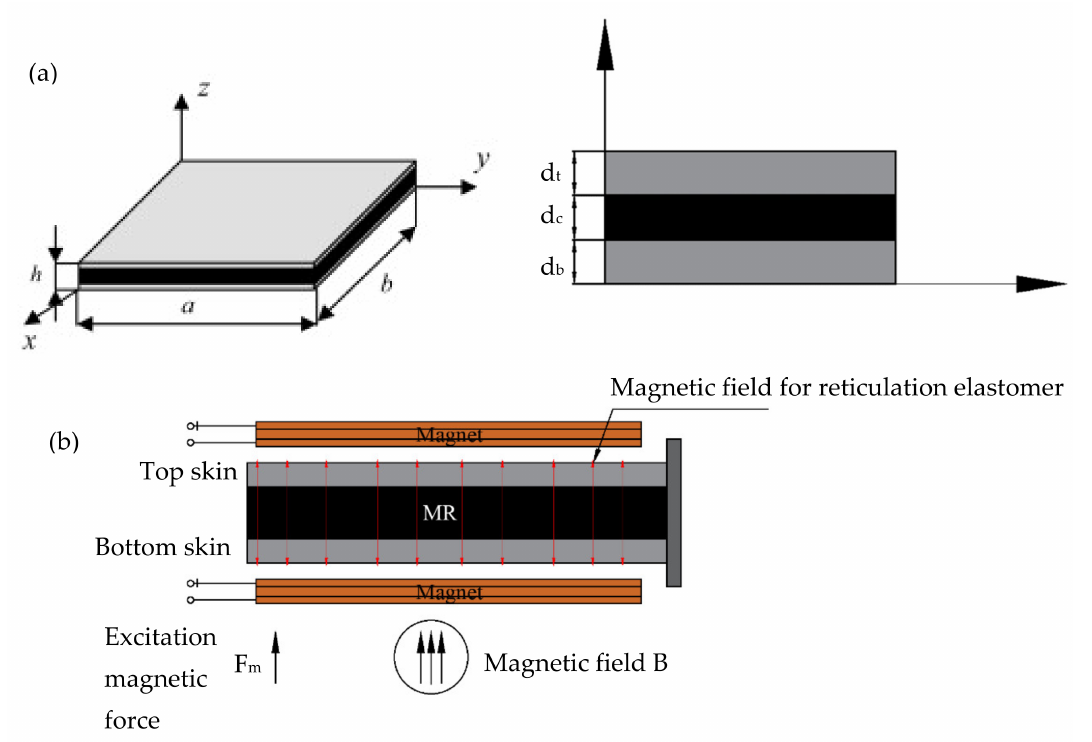
Figure 14. ( a ) Sandwich plate with the elastomer part; ( b ) Vibrating sandwich plate subjected to a perpendicular magnetic field [96].